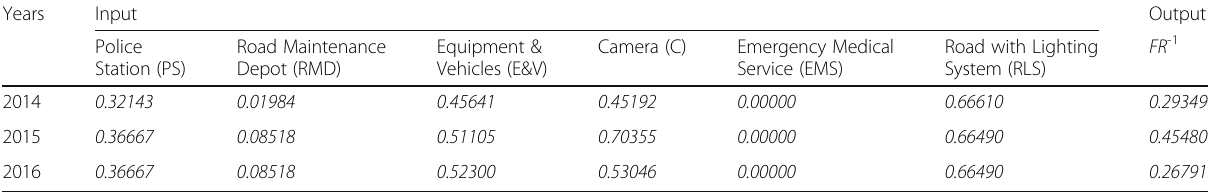
Table 12 Data analysis. Deviations of the input and output variables for Qom province Years